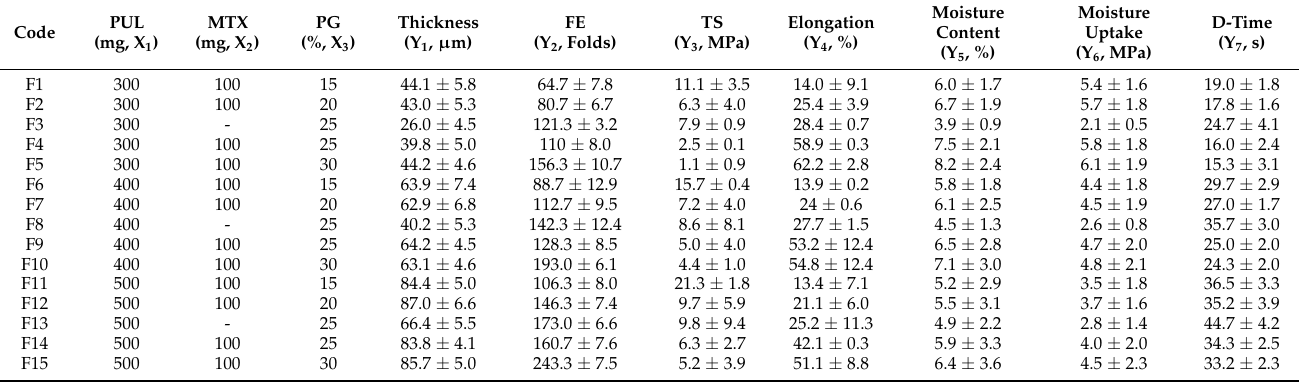
Table 1. Box–Behnken experimental design of three independent variables (X 1 , X 2 , and X 3 ) and their respective influences on the corresponding responses (Y 1 , Y 2 , Y 3 , Y 4 , Y 5 , Y 6 and Y 7 ). All values are presented as mean ± SD ( n =